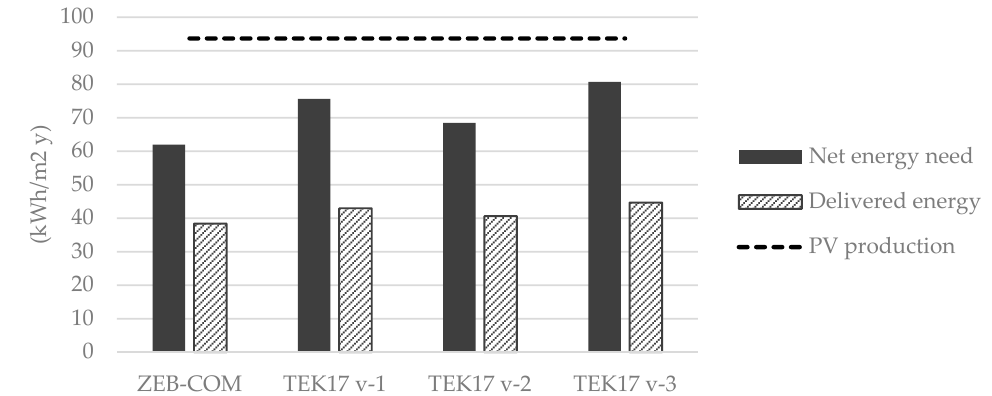
Figure 1. Net energy need and delivered energy of the four designs simulated with the Trondheim climate.